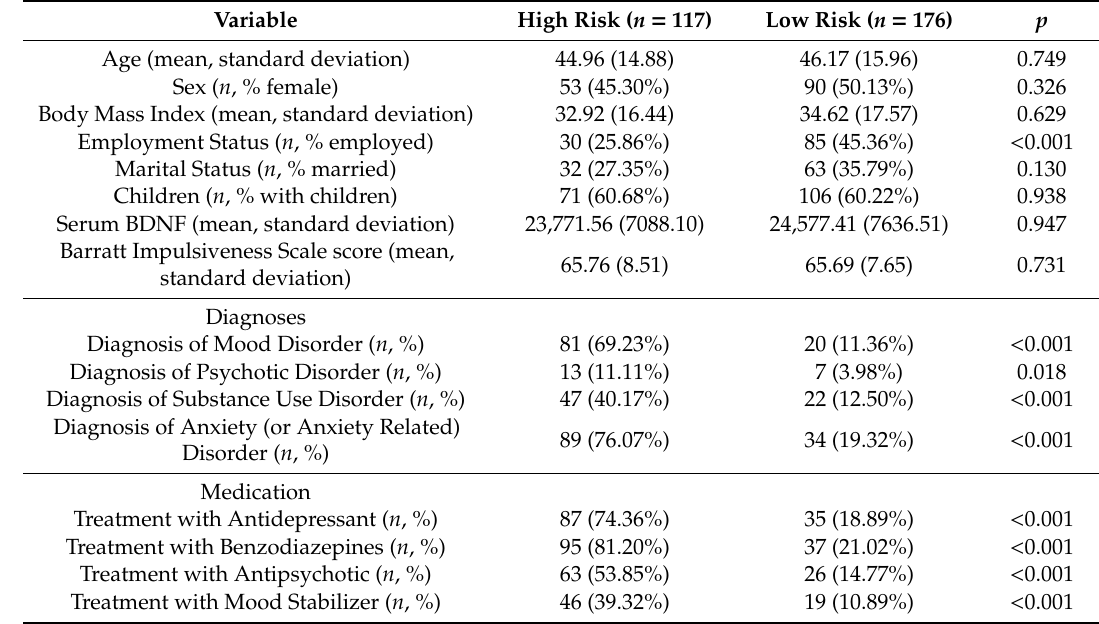
Table 2. Characteristics of study populations by risk